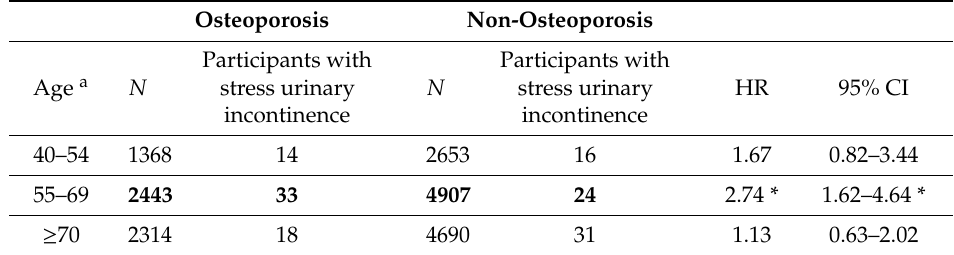
Table 3. Subgroup analysis of the osteoporosis and non-osteoporosis groups in terms of the presence of urinary incontinence using the Cox proportional hazard